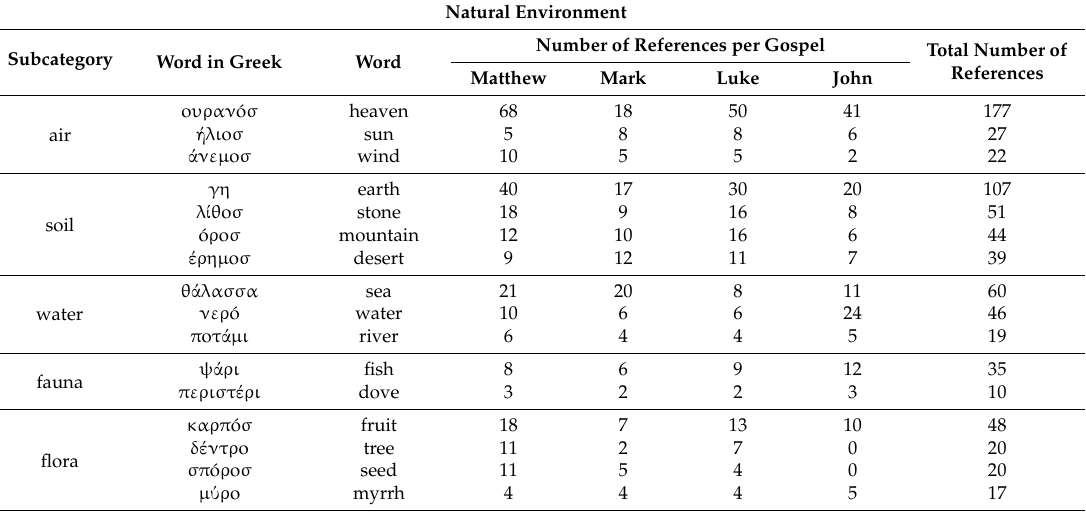
Table A1. List of Most Common